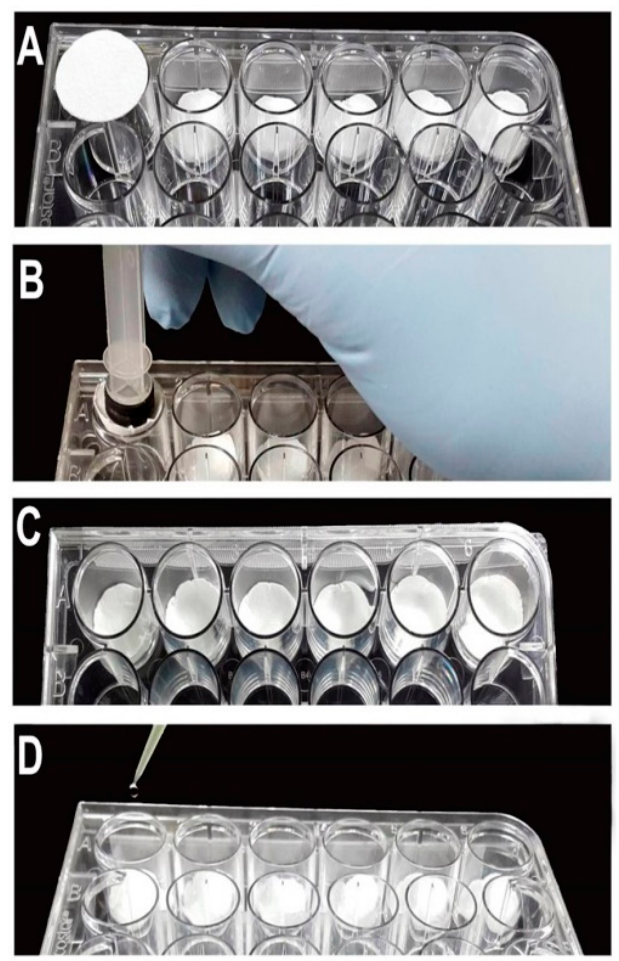
Figure 2. Steps to setup the oviplates using a 24-well plate. ( A ) Place the filter paper (2.0 cm diameter) on the well. ( B ) Push down the filter paper using a 5.0 mL syringe plunger. ( C ) Experimental wells with the filter paper. ( D ) Add 0.125 mL of water in the middle of the filter paper. Table 1. Costs per mosquito tested, amount of cotton, filter paper diameter, and volume of water required in different methods for oviposition assays.